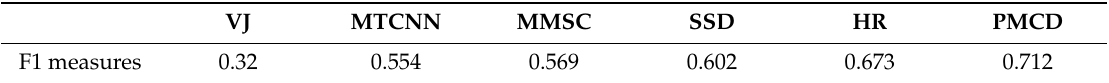
Table 2. The F1 measures of di ff erent methods.